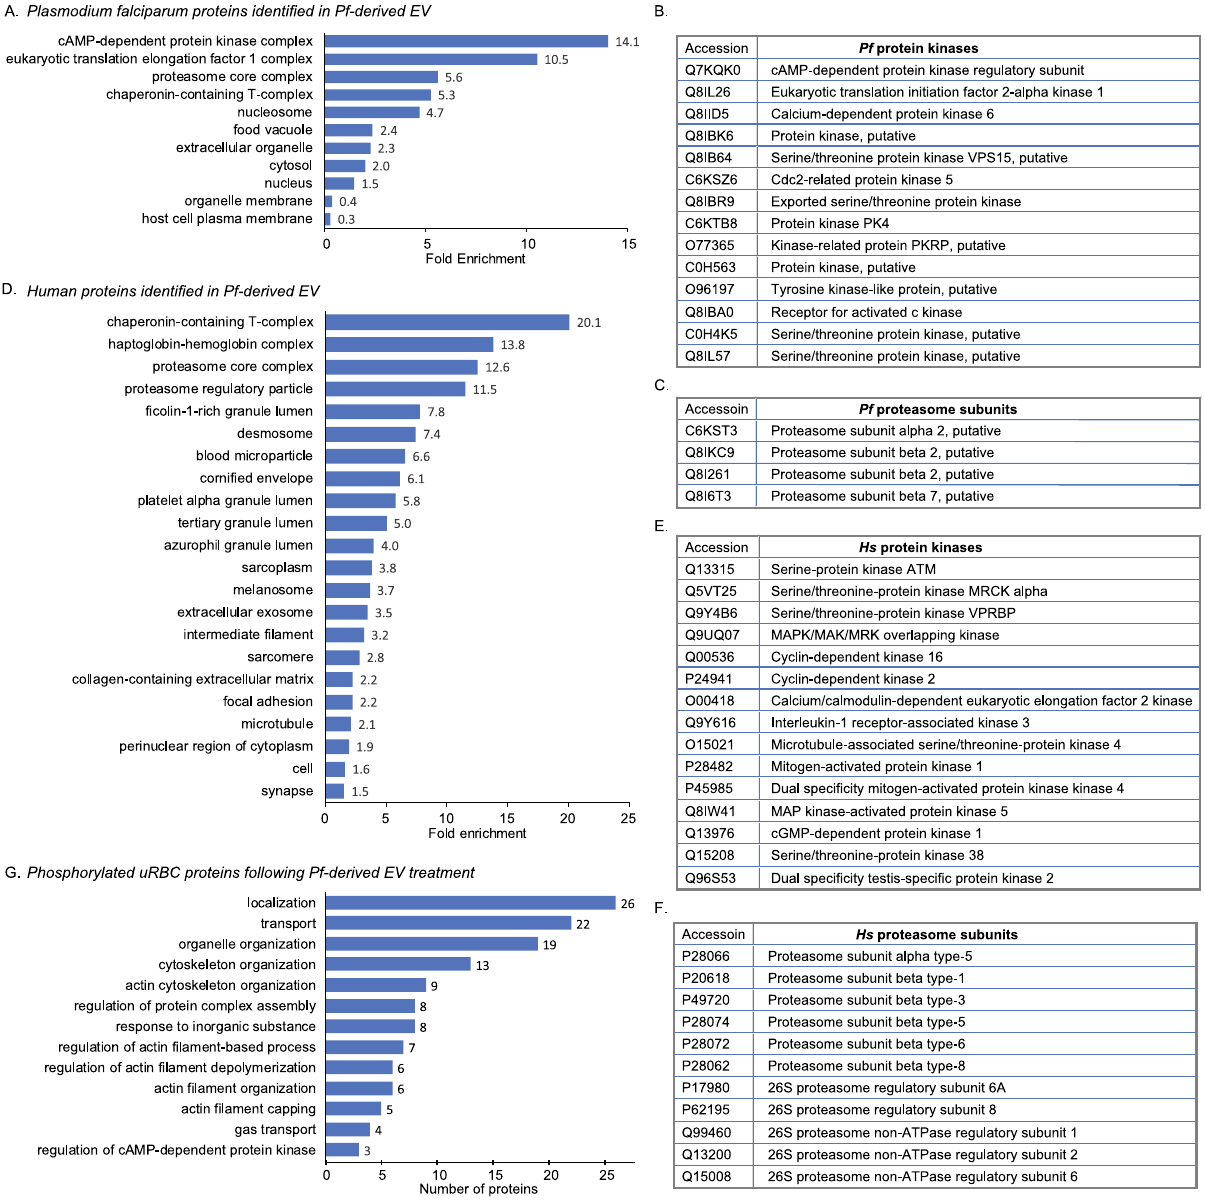
(Fig. 2G). Eight of the 11 cytoskeleton organization proteins comprising the unique phosphosites belong to the same protein cytoskeletal complex, namely, α -adducin (ADD1), β -adducin (ADD2), γ -adducin (ADD3), ankyrin-1 (ANK1), dematin (DMTN), Ebp41, spectrin α − chain (SPTA1) and spectrin β − chain (SPTB). These fi ndings could underlie the AFM results demonstrating signi fi cant alteration of both the stiffness and morphology of the cytoskeleton.